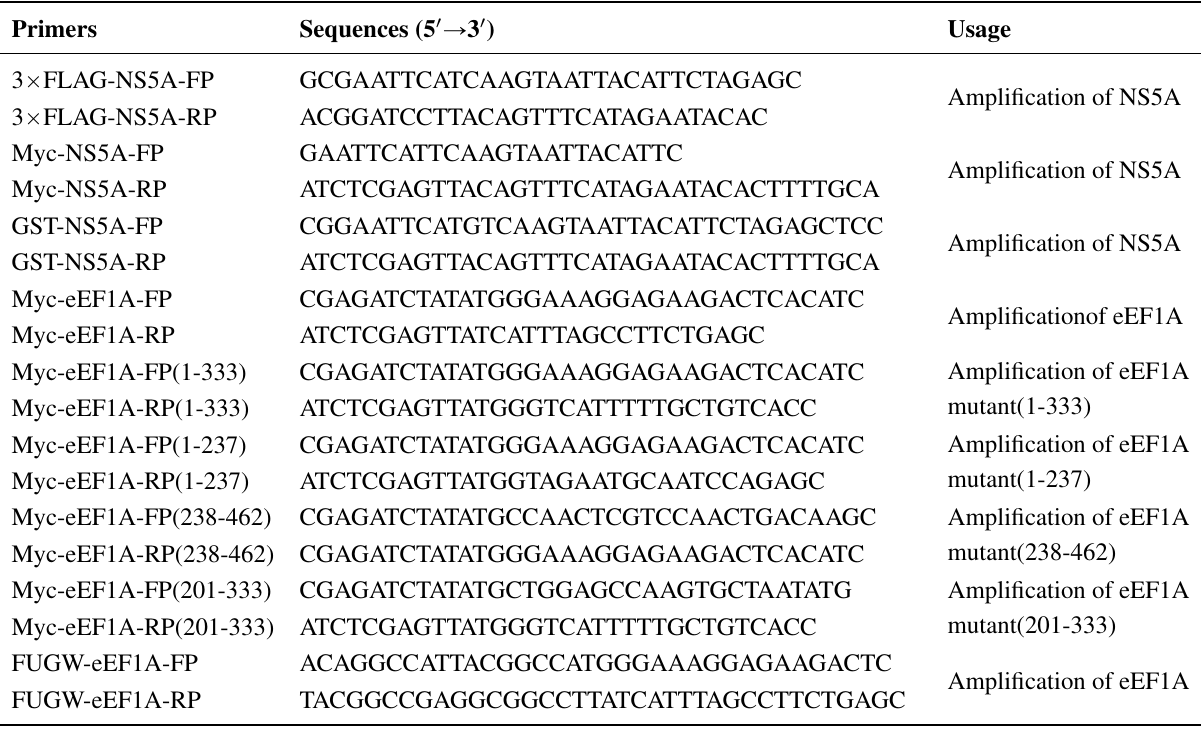
Table 1. Primers used in this